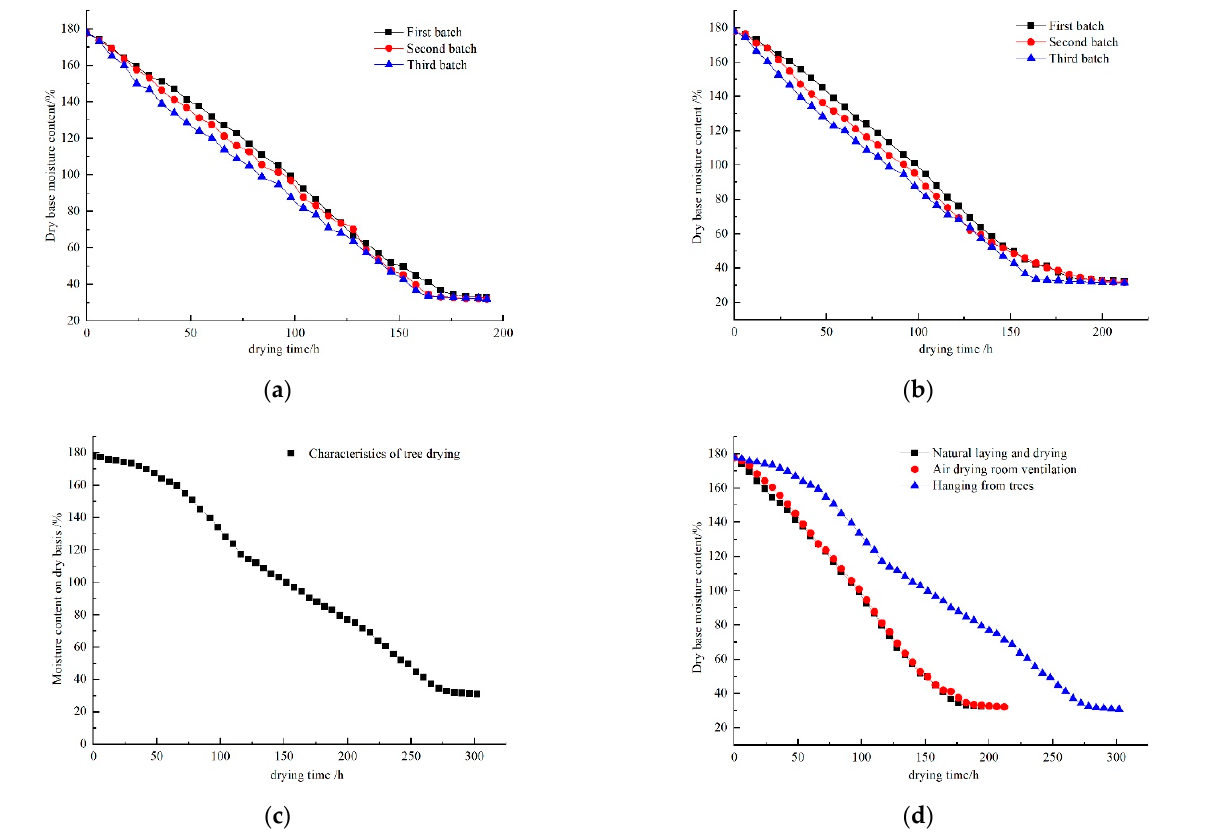
Figure 2. Change rule of moisture content of apricot under different drying methods.( a ) Variation law of dry moisture content in natural placement, ( b ) Variation law of moisture content of air drying house, ( c ) Water content change rule of tree hanging dry way, ( d ) Comparison of moisture content change of three drying methods